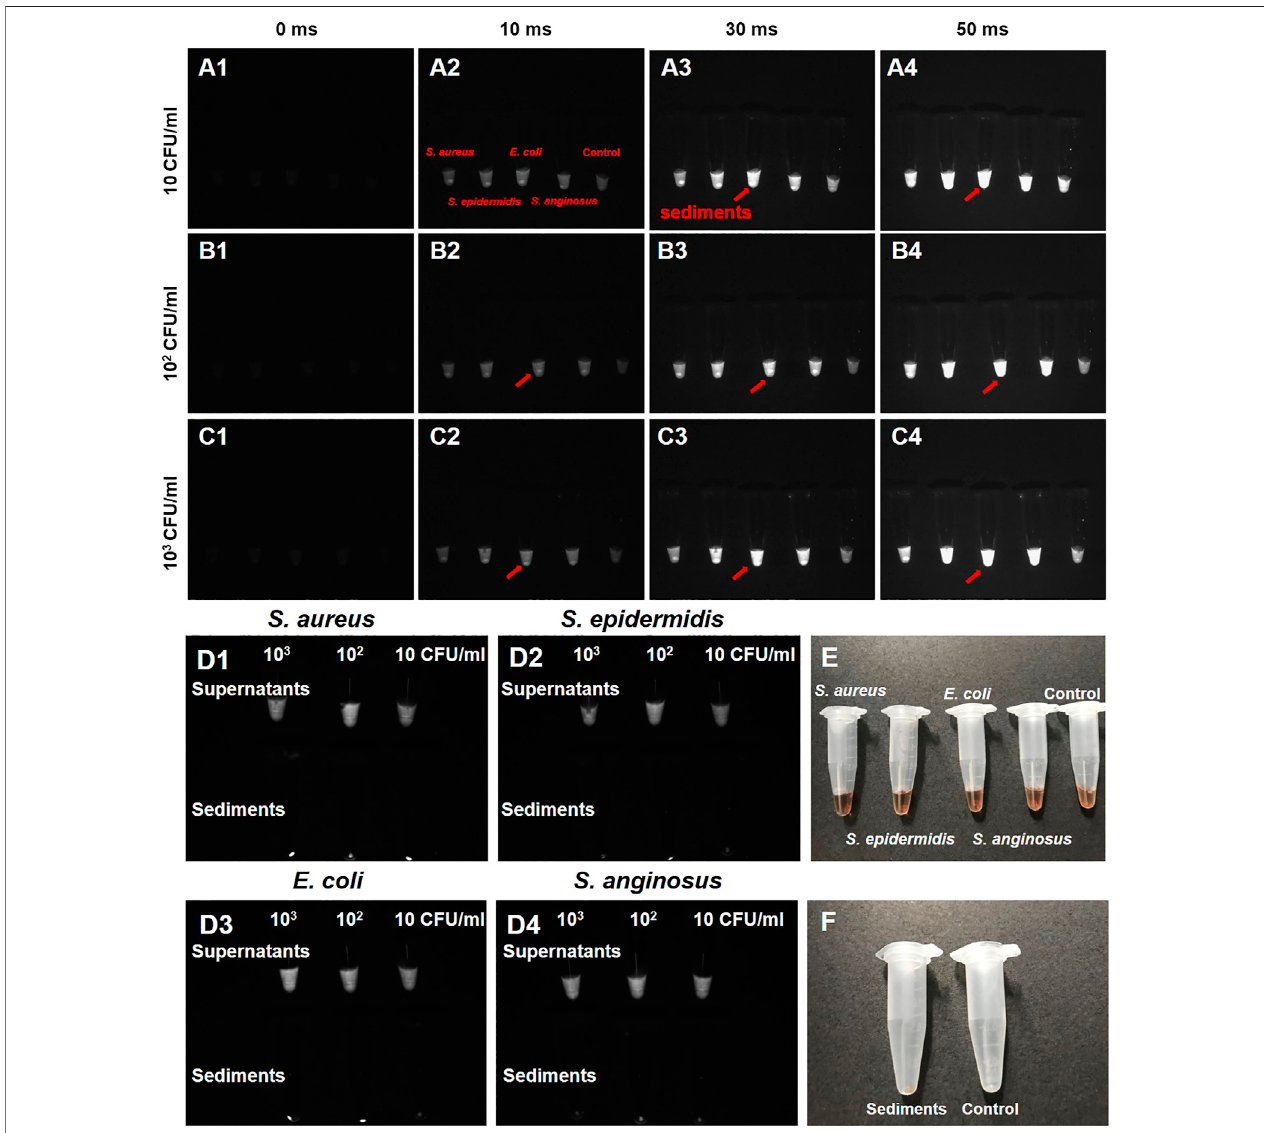
FIGURE 2 | (A – C) NIR-II fl uorescence images of four bacteria strains ( S. aureus , S. epidermidis , E. coli and S. anginosus ) co-cultured with PbS QDs under an exposuretimeof0 ms,10 ms,30 msand50 msatabacterialconcentration of10 CFU/ml, 10 2 CFU/mland10 3 CFU/mlincomparison withacontrolgroup(redarrow: sediments presenting high fl uorescence signal). (D1 – D4) NIR-II fl uorescence images of supernatants and bacterial sediments after co-culture. (E) Bright- fi eld photograph of (A) . (F) Bright- fi eld photograph comparing the bacterial sediments and a control group after